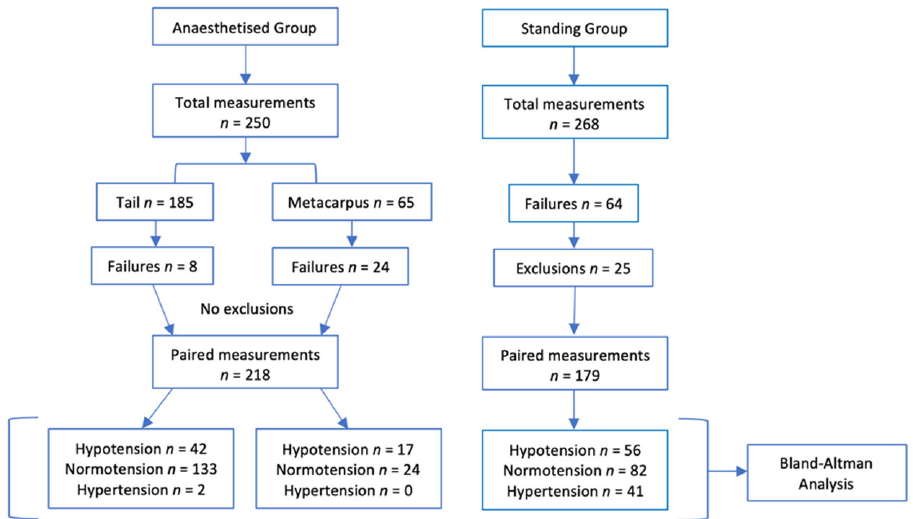
Figure 1. Flow diaphragm for comparing arterial blood pressure measured non-invasively to arterial Figure 1. Pictorial representation of the methodology for comparing arterial blood pressure meas ‐ blood pressure measured invasively using the Bionet BM7Vet in 14 healthy anaesthetised and 9 stand- ured non ‐ invasively to arterial blood pressure measured invasively using the Bionet BM7Vet in 14 ing horses. Failures occurred when the Bionet BM7Vet failed to generate a non-invasive arterial blood healthy anaesthetised and 9 standing horses. Failures occurred when the Bionet BM7Vet failed to pressure measurement by the completion of the inflation cycle. Paired measurements were excluded generate a non ‐ invasive arterial blood pressure measurement by the completion of the inflation cy ‐ from the analysis when the pulse rate measured by the non-invasive method differed by ≥ 20% to the cle. Paired measurements were excluded from the analysis when the pulse rate measured by the true pulse rate. Anaesthetised group: hypotension ≤ 70 mm Hg, normotension 71–110 mm Hg, hy- non ‐ invasive method differed by ≥ 20% to the true pulse rate. Anaesthetised group: hypotension ≤ pertension ≥ 111 mm Hg. Standing group: hypotension ≤ 90 mm Hg, normotension 91–125 mm Hg, 70 mm Hg, normotension 71–110 mm Hg, hypertension ≥ 111 mm Hg. Standing group: hypotension hypertension ≥ 126 mm Hg. No. number, SD standard deviation, LOA limits of agreement, U upper and L lower, MAP mean ≤ 90 mm Hg, normotension 91–125 mm Hg, hypertension ≥ 126 mm Hg. arterial pressure. Bias defines accuracy and SD defines precision. The non ‐ invasive arterial blood Individual horse trajectory plots (Supplementary Figure S1) indicated trends of IBP- pressure cuff was placed either at the proximal tail base or the metacarpus. Combined recordings NIBP variation differed between NIBP cuff location. As a result, paired ABP measurements on the proximal tail base (pooled) were separated into hypotension (MAP ≤ 70 mm Hg), normoten ‐ were separated by NIBP location (tail, metacarpus) for the Bland–Altman analysis presented in Table 2, Figures 2 and 3 and Supplementary Figures S2 and S3. Due to the limited number sion (71 ≤ MAP ≤ 110 mm Hg) and hypertension (MAP ≥ 111 mmHg). of paired ABP measurements, metacarpal data remained pooled for the statistical analysis.